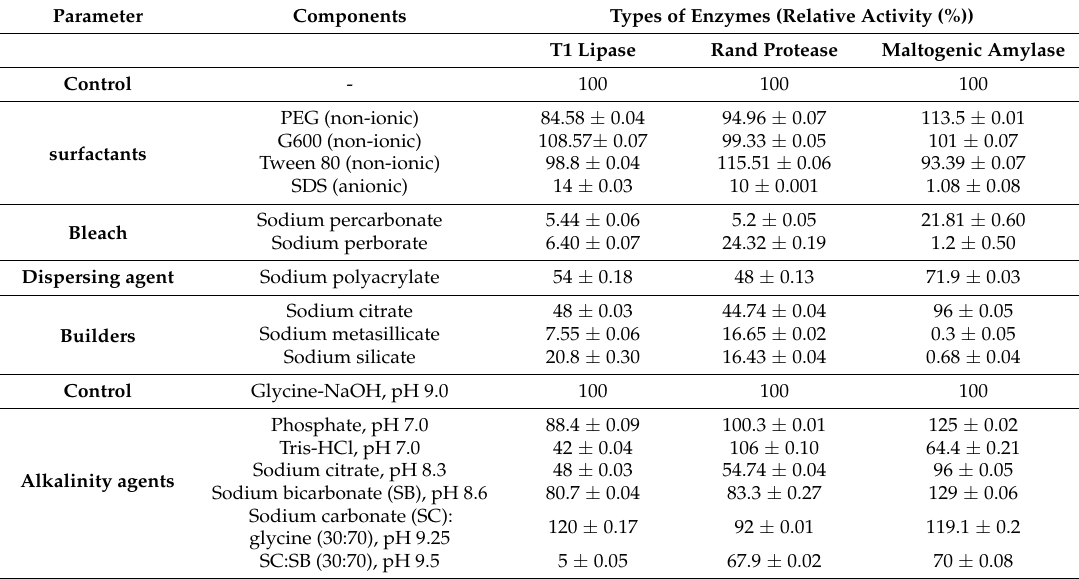
Table 1. Stability of enzymes in 0.2% ( v / v ) or ( w / v ) of various surfactants, bleach, dispersing agent, builders and alkalinity